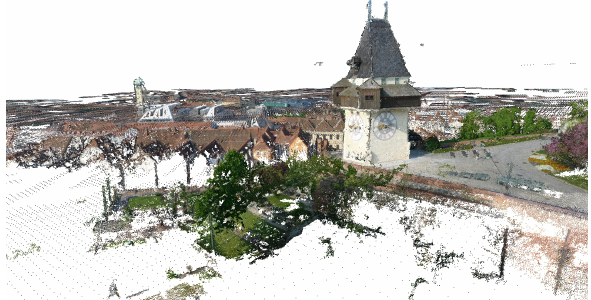
Figure 5: Fusion and geo–referencing of partial